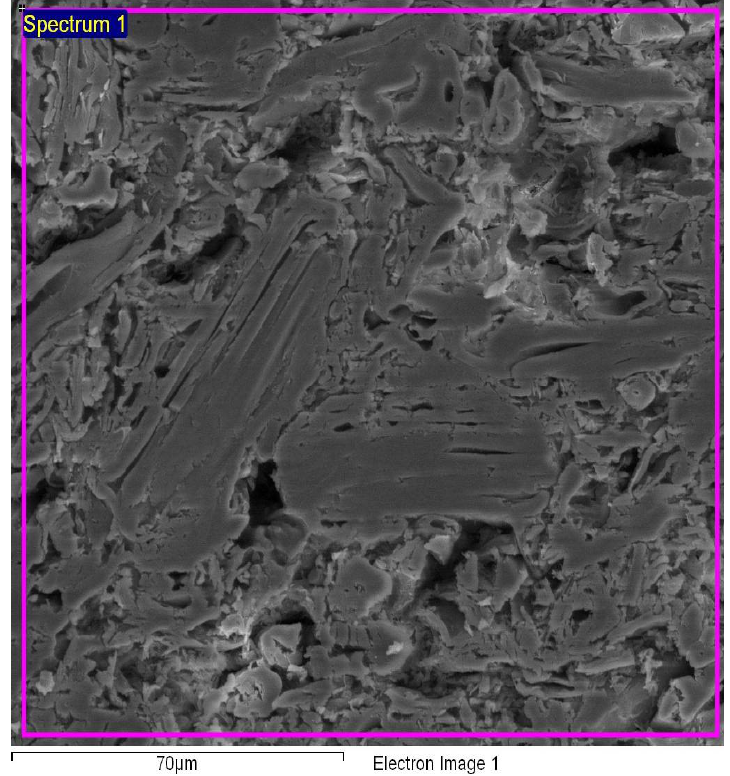
Figure 8. Micrograph of Rhizophora spp. particleboard bonded with 6% binders.